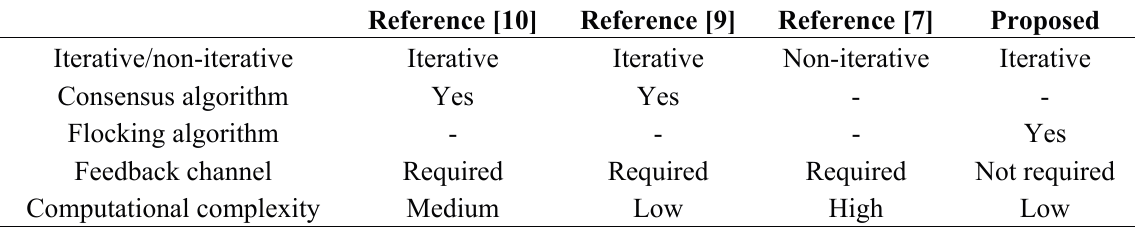
Table 1. Comparison of distributed synchronization techniques for OFDMA-based WMSs. Reference [10] Reference [9] Reference [7] Proposed Iterative/non-iterative Iterative Iterative Non-iterative Iterative Consensus algorithm Yes Yes - - Flocking algorithm - - -